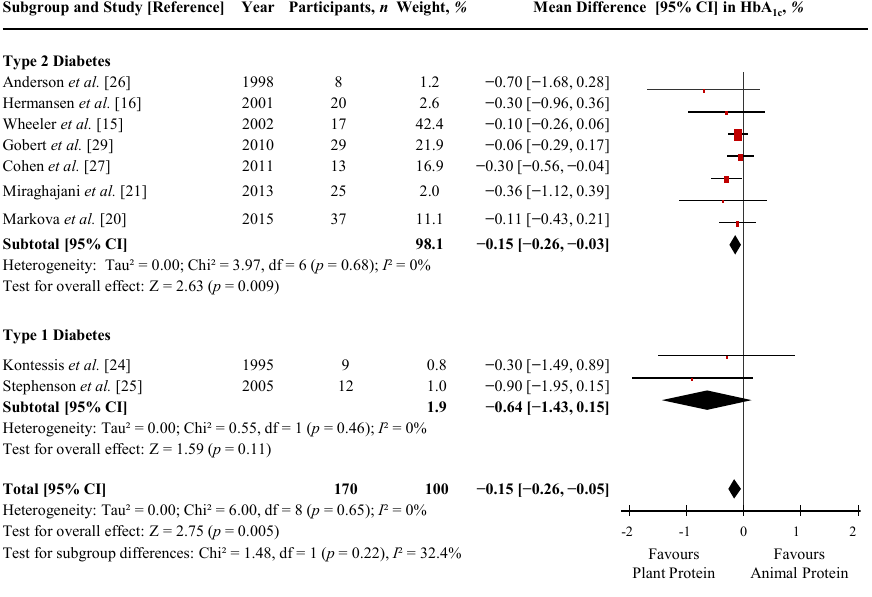
Figure 2. Forest plot of randomized controlled trials investigating the effect of replacing sources of animal with plant protein in individuals with diabetes on hemoglobin A1c (HbA 1c ). Pooled effect estimates for each subgroup and overall effect are represented by the diamonds. Data are expressed as weighted mean differences with 95% confidence intervals (CIs), using the generic inverse-variance method with random effects models. Paired analyses were applied to all crossover trials. Inter-study heterogeneity was tested by the Cochran Q-statistic and quantified by I 2 at a significance level of p < 0.10; d f , degrees of freedom.